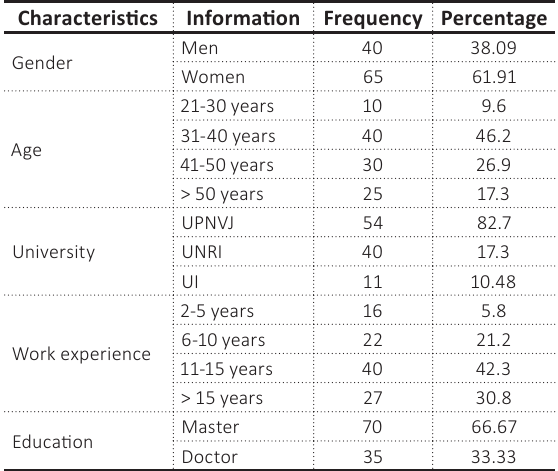
Table 2. Description of respondents